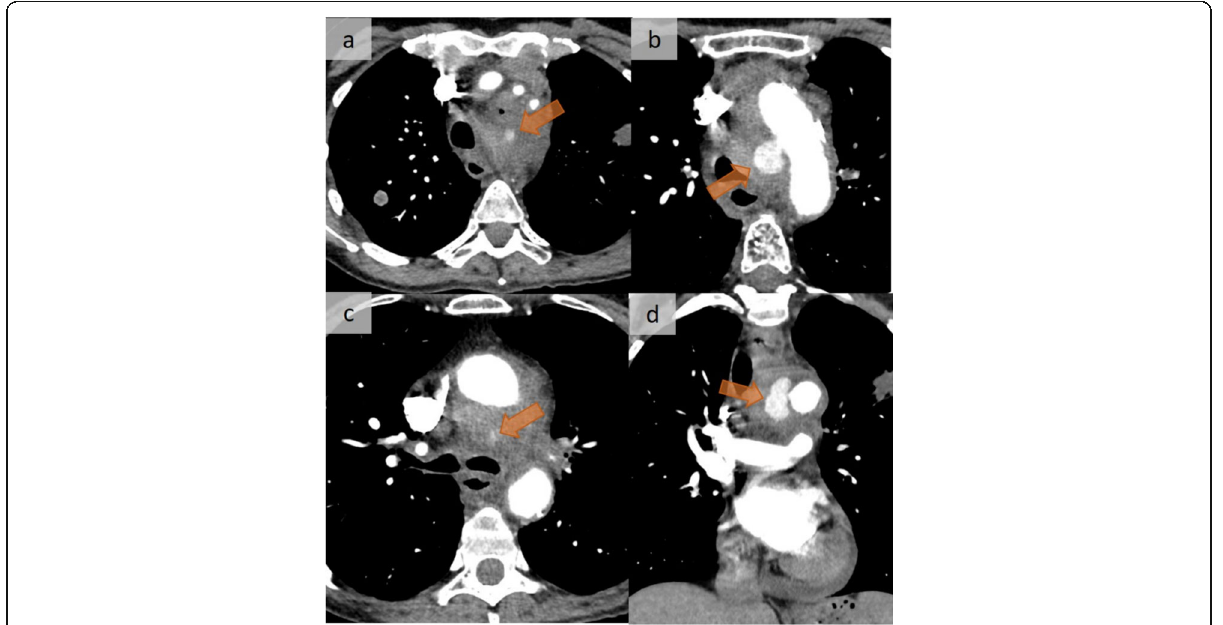
Fig. 7 Post-mediastinitis aneurysm. Fatal, false aneurysm complicating a mediastinitis following an EBUS procedure. EBUS had been performed in the context of a suspicion of stage IV lung cancer. Contrast-enhanced CT was performed 35days after EBUS because the patient complained of chest pain. Successive axial CT images ( a – c ) show a diffuse infiltration of the mediastinal fat with a false aneurysm (arrow) that developed on the right side of the aortic arch. Coronal reformation shows the cranio-caudal extent of the false aneurysm (arrow) ( d ). A pericardial effusion is